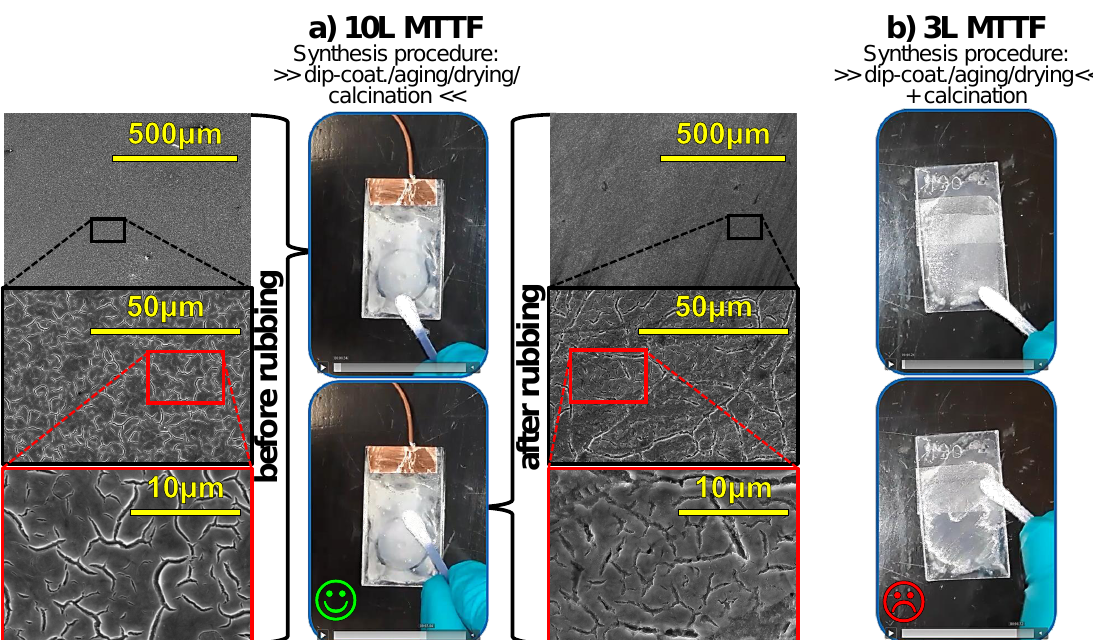
Figure 13. Two different samples before and after the “rubbing test”. ( a ) Photograph and SEM top-view images of the 10-layered MTTF “550 ◦ C_A” from Figure 12. Although its microscopic structure is affected by the rubbing, this sample has delivered stable photocurrents prior and after this procedure. ( b ) Photograph of a 3-layered MTTF that had been calcined only once to save energy and time, namely after the drying phase of its third and last deposition cycle. This film is not mechanically